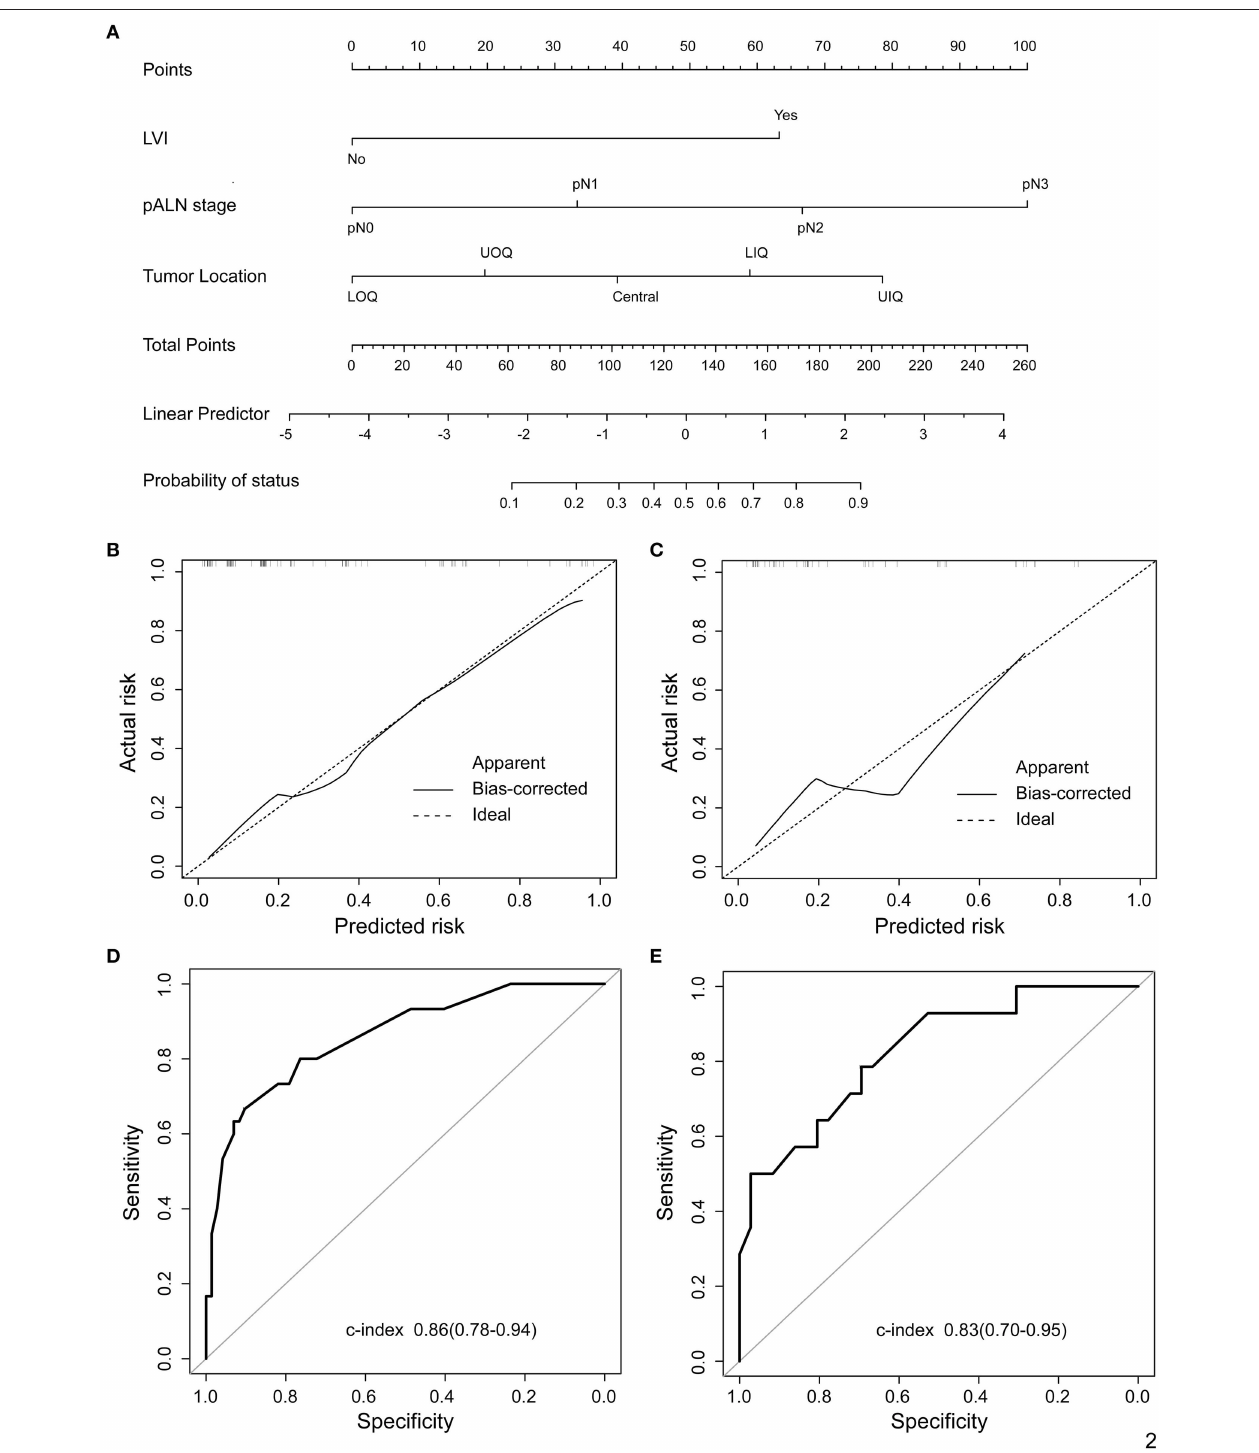
FIGURE 2 | Proposed nomogram to predict the probability of IMLN metastasis after mastectomy in patients with breast cancer. (A) Nomogram was build to predict IMLN status for BC patients, with the tumor location, LVI and pALN stage incorporated. Calibration plots for nomogram model in (B) training cohort and (C) validation cohort. The dashed line (the 45-degree line) represents a perfect prediction nomogram, and the black solid line represents the observed nomogram, of which a closer fit to the dashed line means a better prediction model. Plots (D) and (E) show the ROC curves of the constructed nomogram in the training and validation cohorts, respectively. UIQ, upper inner quadrant; LIQ, lower inner quadrant; UOQ, upper outer quadrant; LOQ, lower outer quadrant.